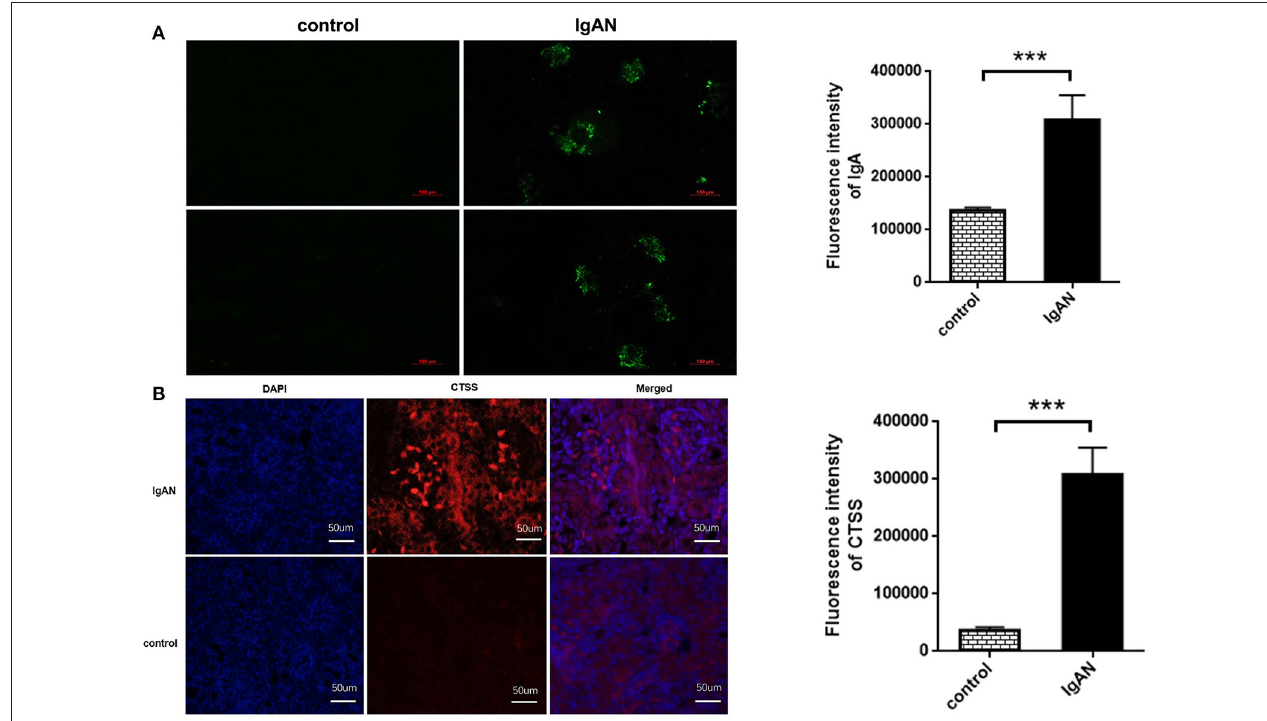
FIGURE 3 | Immunofluorescent analysis of IgA accumulation and CTSS expression in the kidney of rats. Following induction of IgAN in rats, the levels of IgA accumulation and CTSS expression in the kidney tissues of experimental and control rats were determined by immunofluorescence. Data are representative images or present as the means ± SD of each group ( n = 10 per group) from three separate experiments. (A) IgA accumulation in the mesangium of IgAN rats. (B) Up-regulated CTSS expression in the kidney of IgAN rats. *** P < 0.001 vs. the control.